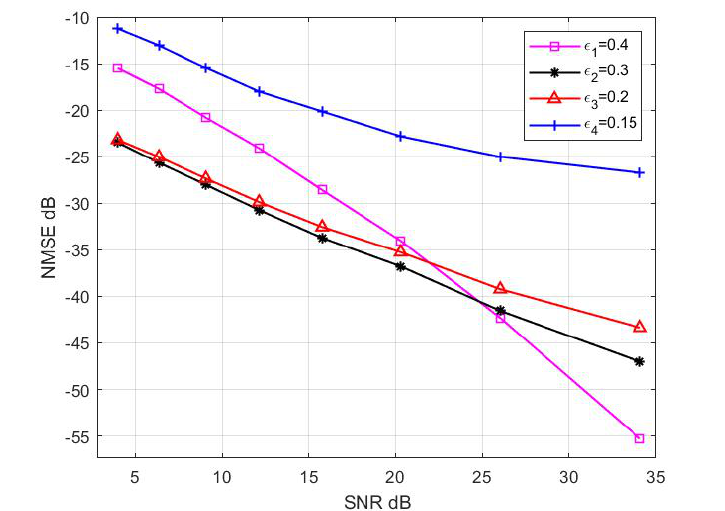
Figure 11. The effect of (cid:101) on the